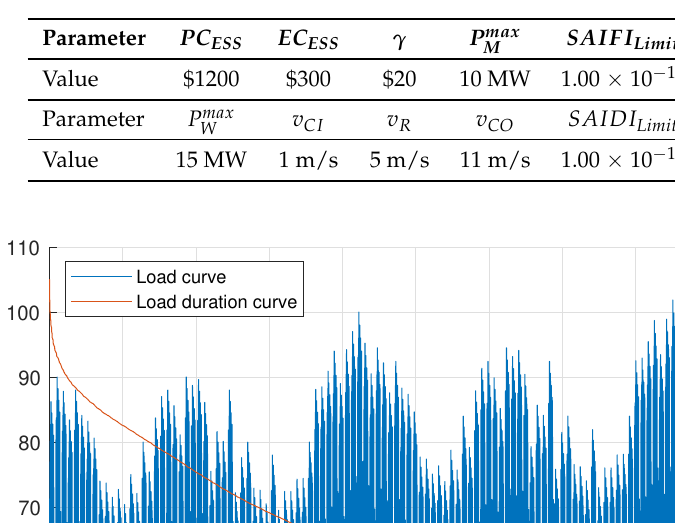
Table 5. Values of other model parameters.